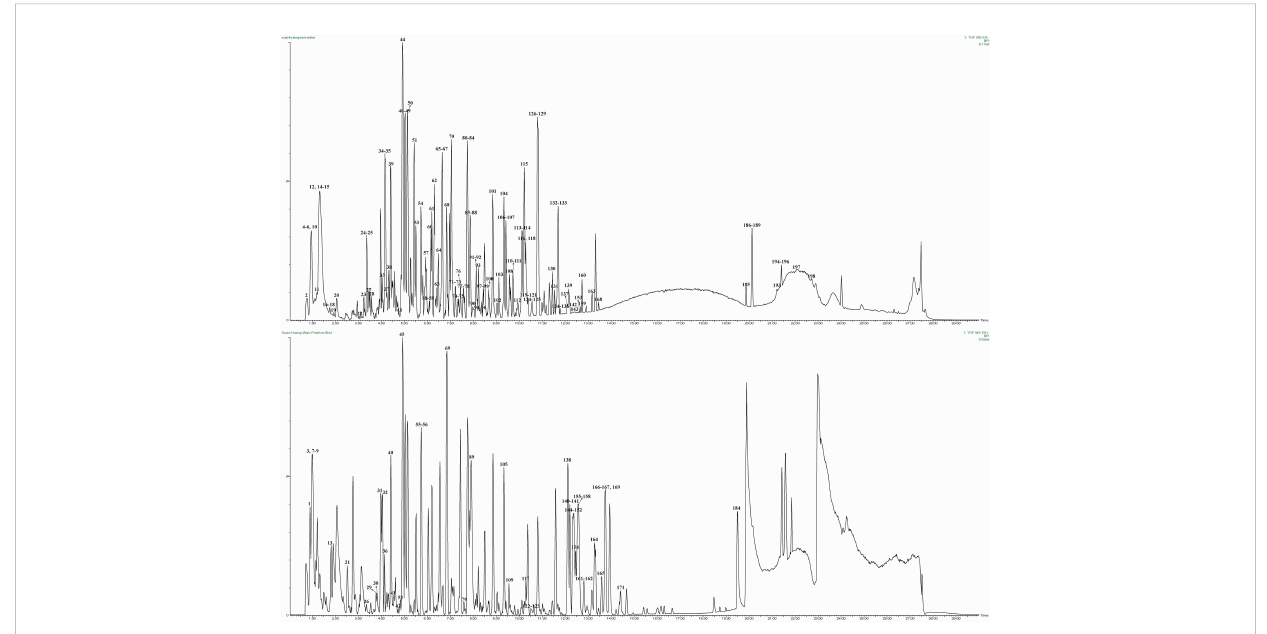
FIGURE 2 BPI chromatograms of XHP obtained by UPLC-QTOF/MS. The top picture was negative ions, and the bottom picture was positive